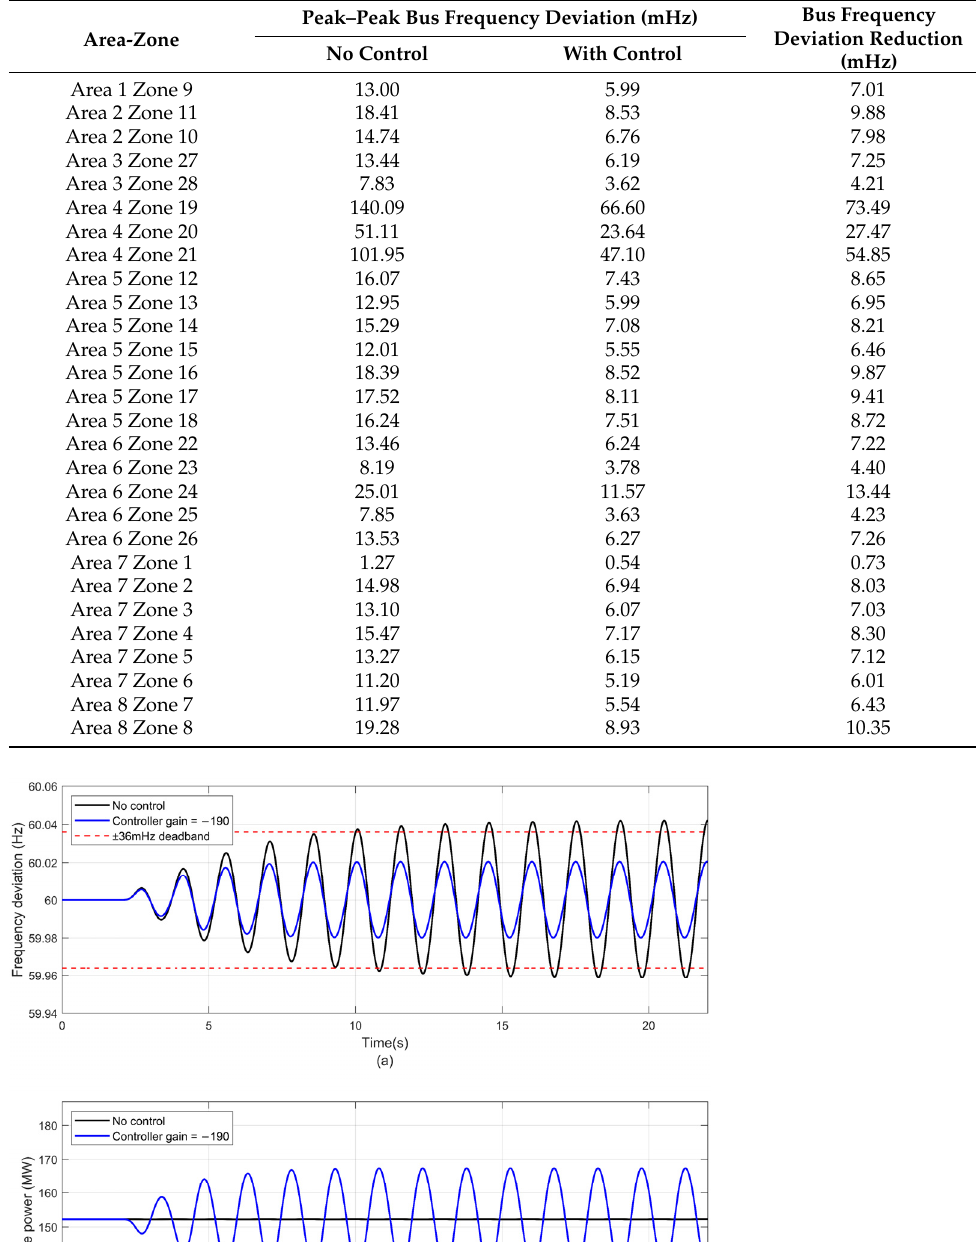
Table 5. The peak–peak bus frequency deviation improvement before and after implementing the forced oscillation damping controller.